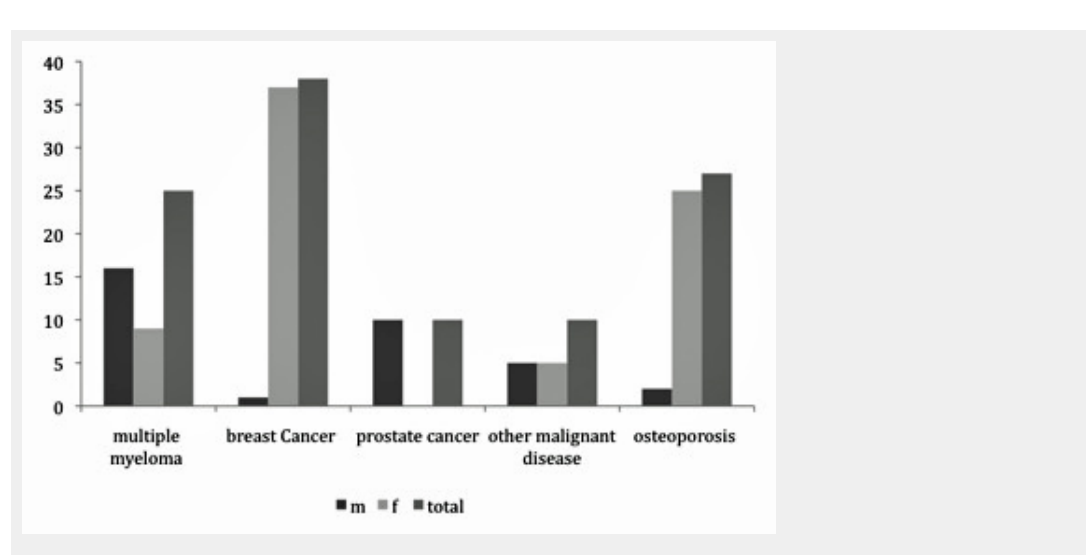
Display of underlying malignant disease and gender distribution of all patients (m = male; f = female).